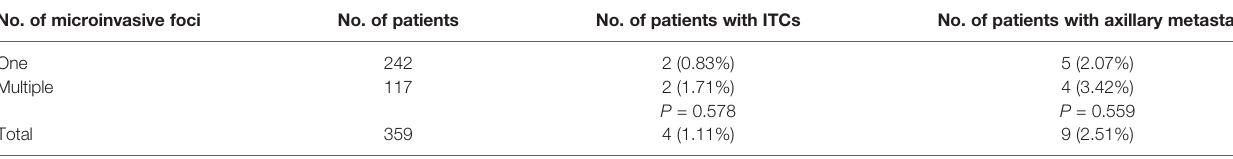
TABLE 2 | Number of microinvasive foci and rate of axillary metastasis with P values for comparison of rates between groups. No. of microinvasive foci